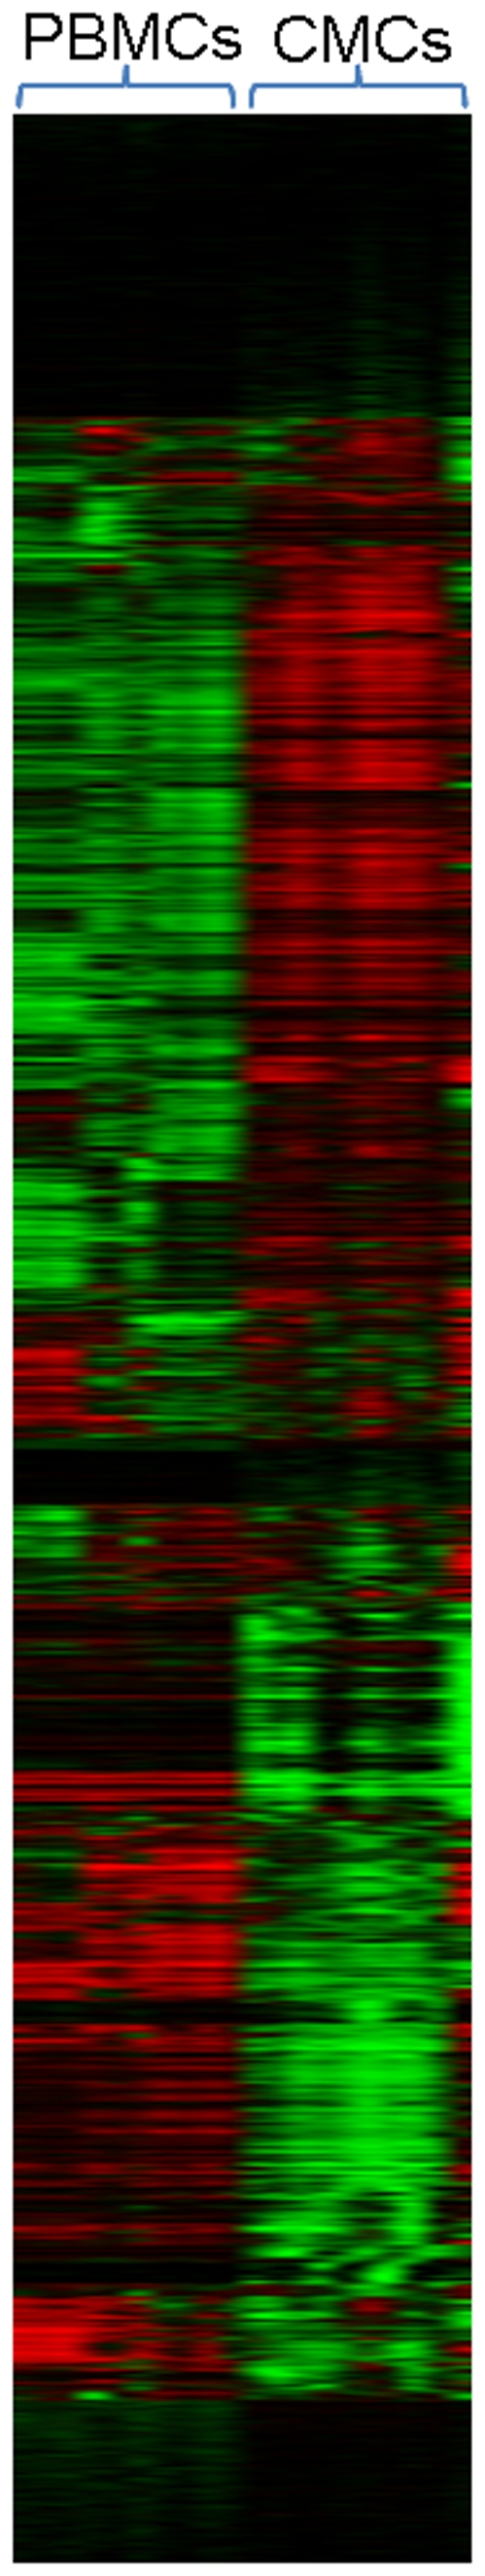
Overall gene expression in matched CMCs and PBMCs.CMCs and PBMCs cluster independently using unsupervised hierarchical clustering. Red indicates a relative increase in gene expression intensity and green represents a relative decrease in gene expression intensity in the sample.